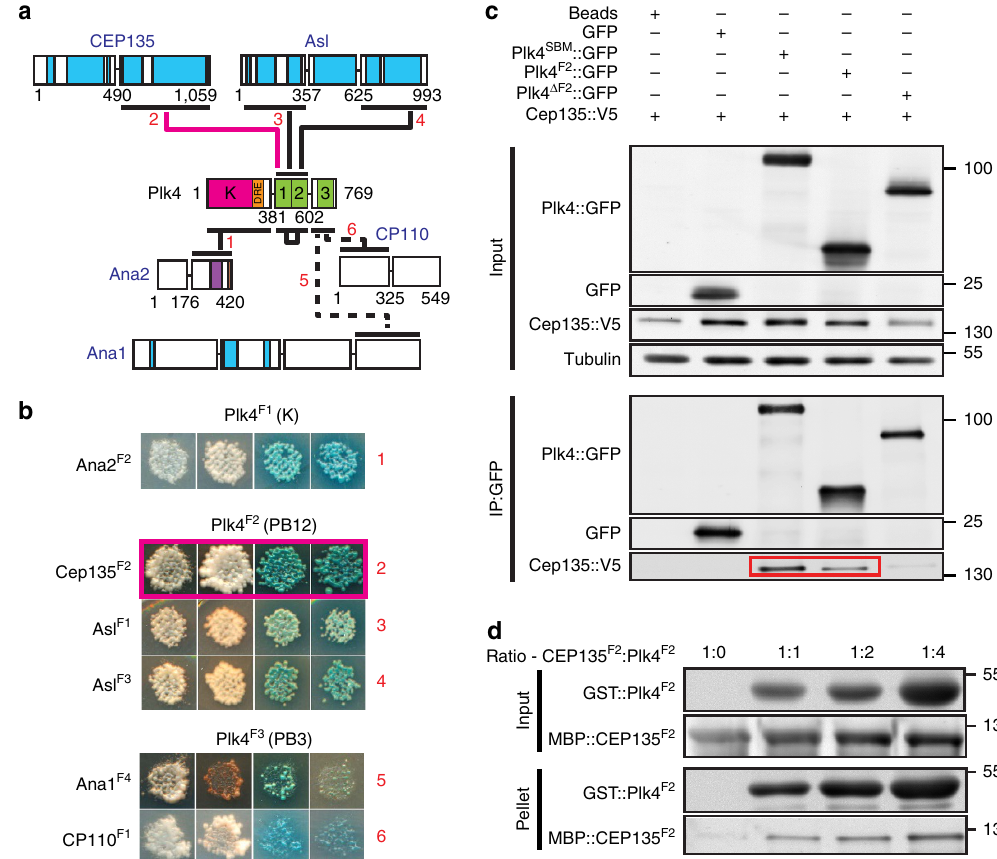
Figure 5 | Plk4 interacts with Cep135. ( a ) All Plk4 interactions identified in screen (red numbers refer to b ). Pink line highlights the interaction of Cep135 and Plk4. Schematics as in Fig. 2a. ( b ) Results of Y2H interactions with Plk4. Red numbers refer to interactions indicated in a . Y2H data are arranged as in Supplementary Fig. 1c. Pink box highlights the interaction of Plk4 with Cep135. ( c ) Plk4 F2 (aa 382–602), containing Polo Boxes 1 and 2, is necessary and sufficient for interaction with Cep135. GFP was IP’ed from S2 cells expressing the indicated constructs. Plk4 SBM contains a mutation in the Slimb-binding domain that causes stabilization of Plk4 (ref. 44). Plk4 D F2 is missing residues 382–602 (Polo Boxes 1–2). Red box highlights that Cep135 is Co-IP’ed by Plk4 SBM and Plk4 F2 . Sizes are in kDa. ( d ) Recombinant Plk4 F2 and Cep135 F2 (aa 491–1,059) interact in vitro . Recombinant Plk4 F2 and Cep135 F2 were mixed at the indicated ratios and GST was pulled down. Increasing amounts of Plk4 F2 pull down increasing amounts of